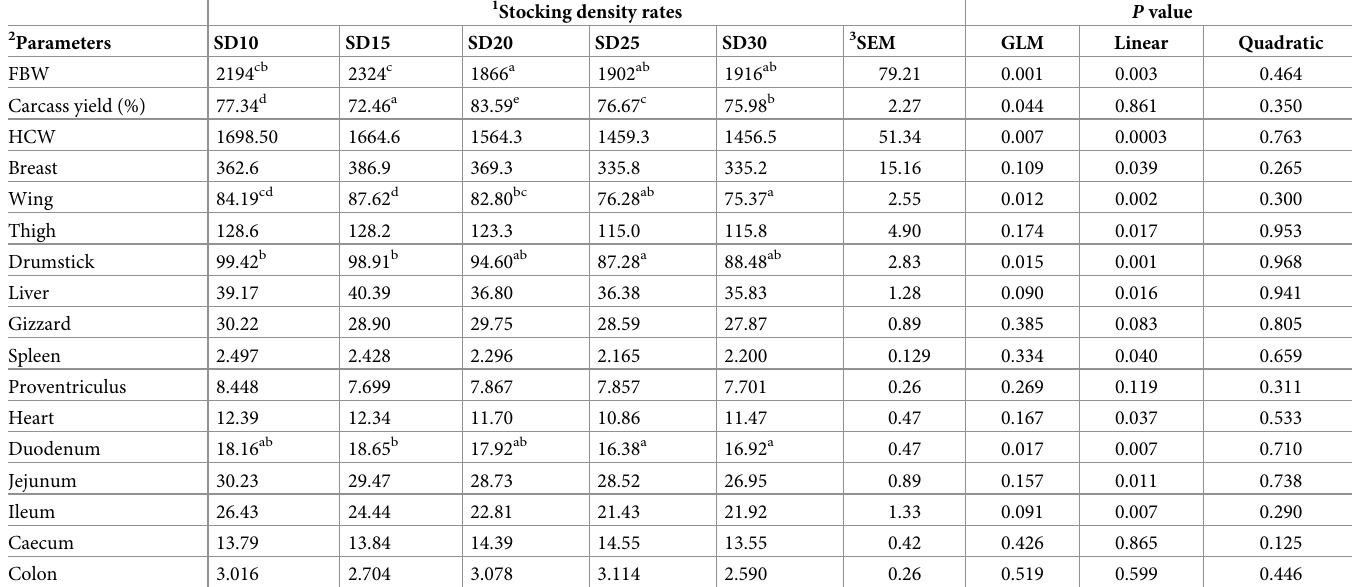
Table 4. The effects of increasing stocking density on carcass characteristics and internal organs (g, unless stated otherwise) of Ross 308 broiler